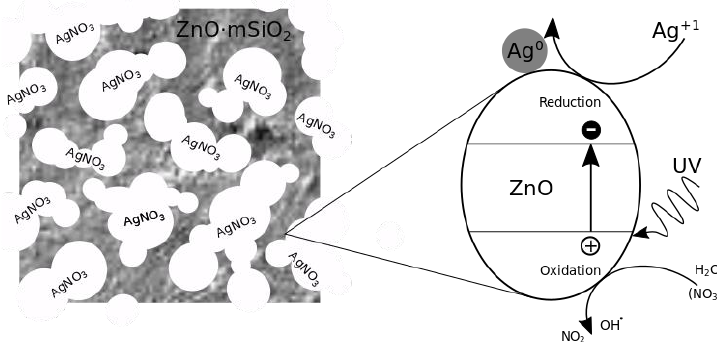
Figure 1. Photoreduction of AgNO 3 on the surface of photocatalytic ZnO within the pore of the silicate substrate ZnO · m SiO 2 . The 200-nm UV light induced an electron-hole charges separation within photocatalytic ZnO. The AgNO 3 was decomposed and Ag +1 reduced to metallic Ag 0 on the surface of ZnO. The limited amount of AgNO 3 within pores of the substrate then caused limited growth of Ag particles.